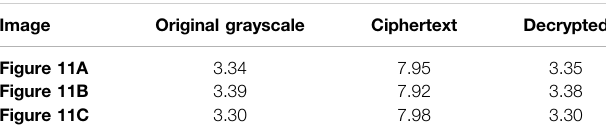
TABLE 1 | Entropy value comparison. Image Original